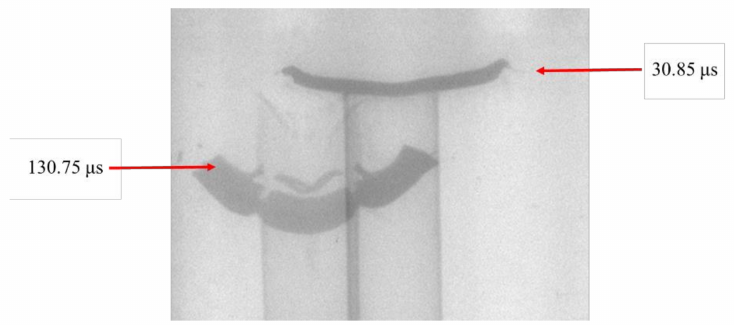
Figure 5. Flash X-ray experiment images at a typical